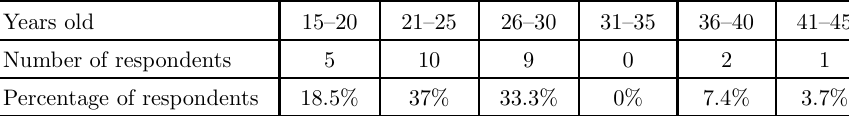
Table 1. Age structure of the respondents